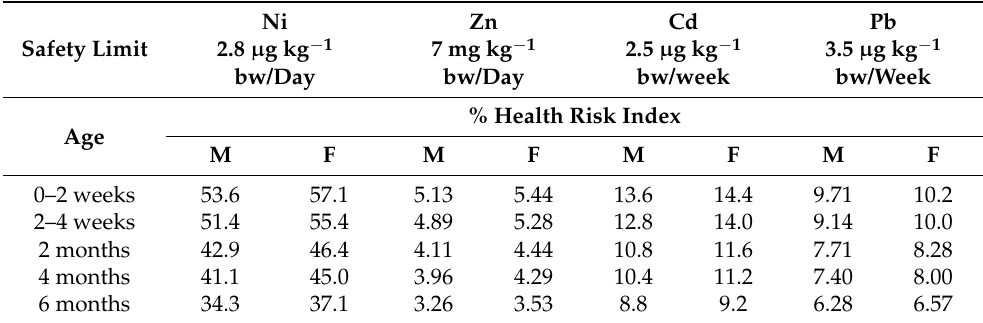
Table 8. Percentage health risk index estimated for infants from 0 to 6 months for Ni, Zn, Cd and Pb, reported separately for males (M) and females